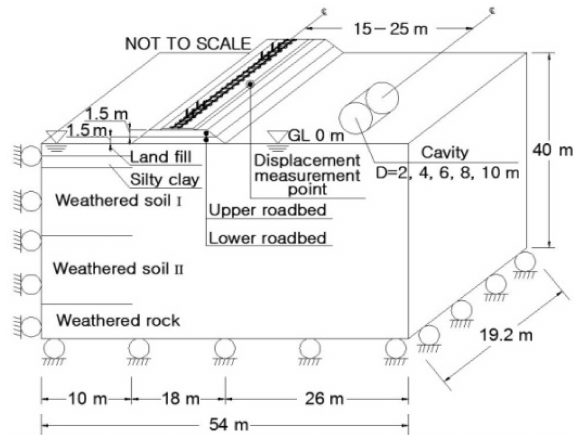
Figure 2. Configuration of the railway roadbed and cavity.